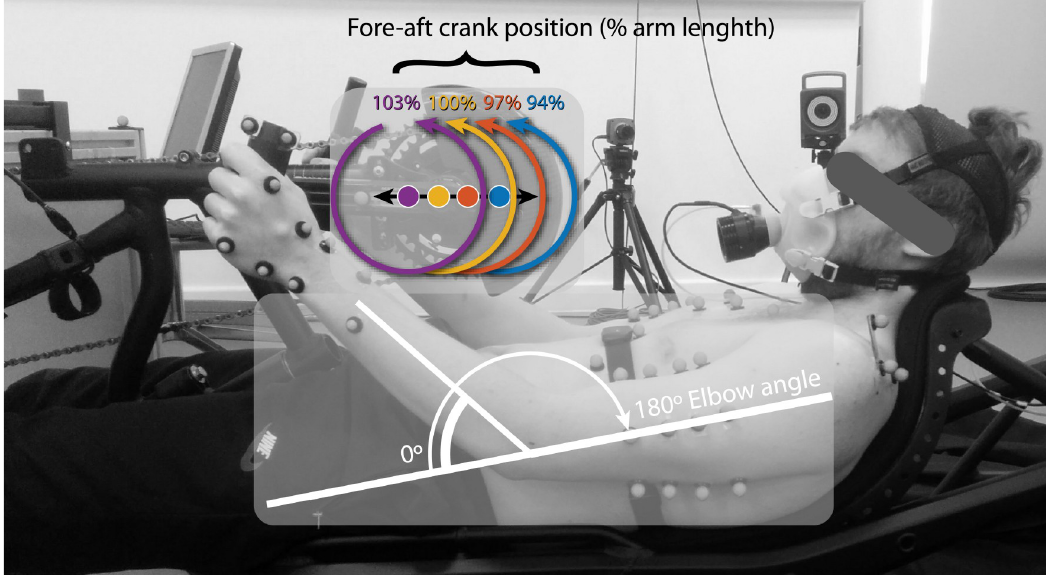
Fig 1. A recumbent handcyclist, in the experimental setup. Four different crank fore-aft configurations were tested, which were standardised at 94%, 97%, 100% and 103% of participants arm length. Elbow flexion was defined as zero in full extension and increased positively when flexed. Shoulder protraction was defined as the angle of the scapula with regard to the y-axis of the local coordinate system of the thorax, where zero meant a parallel position of the two [21].